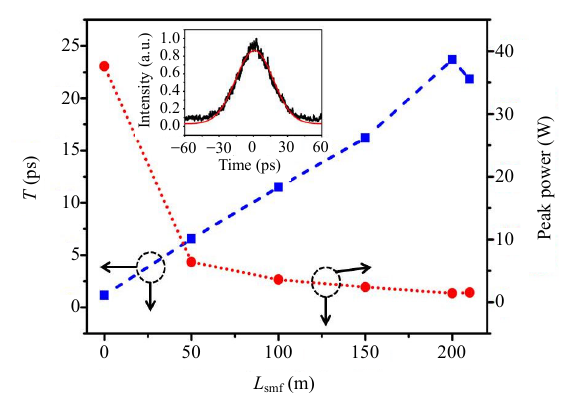
Fig. 5 Tendency of pulse width (blue curve) and peak power (red curve) varying with the access length of the SMF before the pulse amplification. Insert: the autocorrelation trace after the 200-m-long SMF fitted by the Gauss-shaped